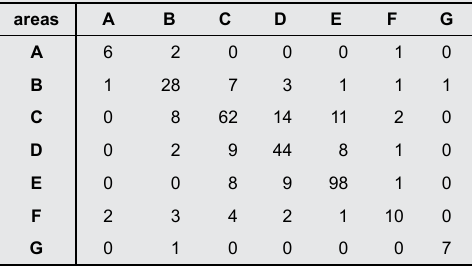
Table 2. Total number of different grey seals recaptured in each area of the Baltic in year 2000 that were released from each area in years 1995 to 1999 or during an earlier trip in year 2000.